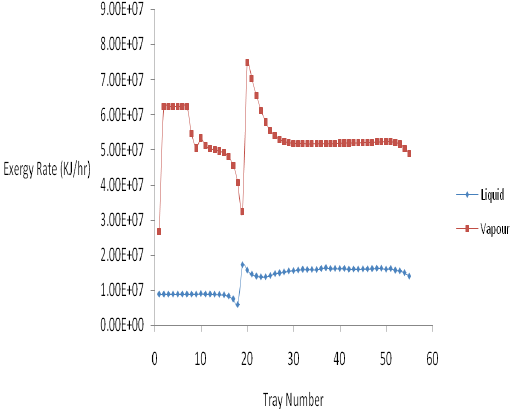
Figure 22. Profile of exergy rate versus tray number for Debutanizer of base case Reflux Ratio